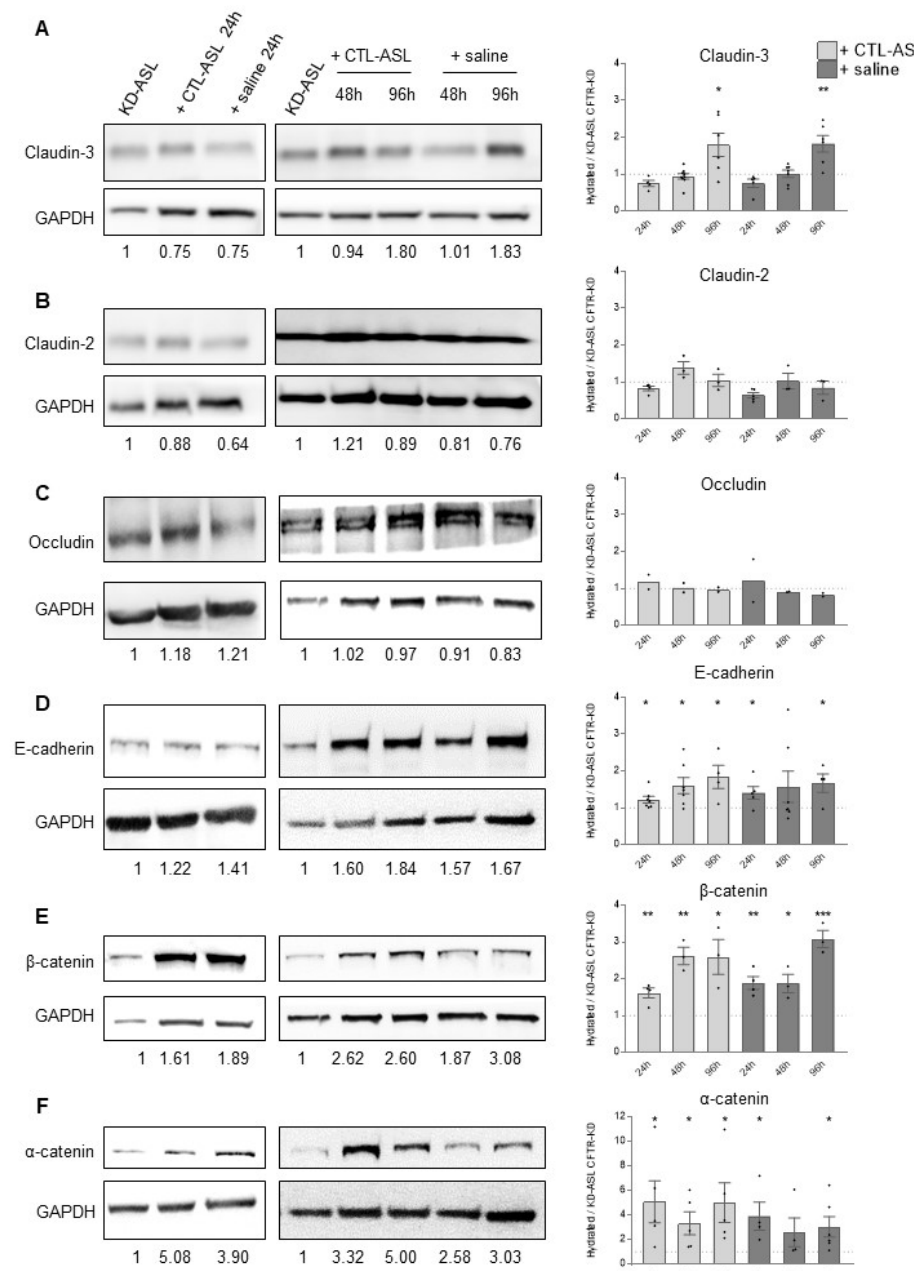
Figure 6. Expression of junctional proteins in the apically rehydrated CFTR-KD epithelium. The amount of junction protein expression was estimated by Western blot and quantified in the CFTR-KD epithelia before and 24 h (left panels), 48, and 96 h (right panels) after apical rehydration with CTL- ASL or physiological saline. Representative Western blot for claudin-3 ( N ≥ 4, n = 1) ( A ), claudin-2 ( N ≥ 3, n = 1) ( B ), occludin ( N = 2, n = 1) ( C ), E-cadherin ( N ≥ 4, n = 1) ( D ), β -catenin ( N ≥ 3, n = 1) ( E ), and α -catenin ( N ≥ 4, n = 1) ( F ). The relative expression level is indicated below each lane. *, **, protein